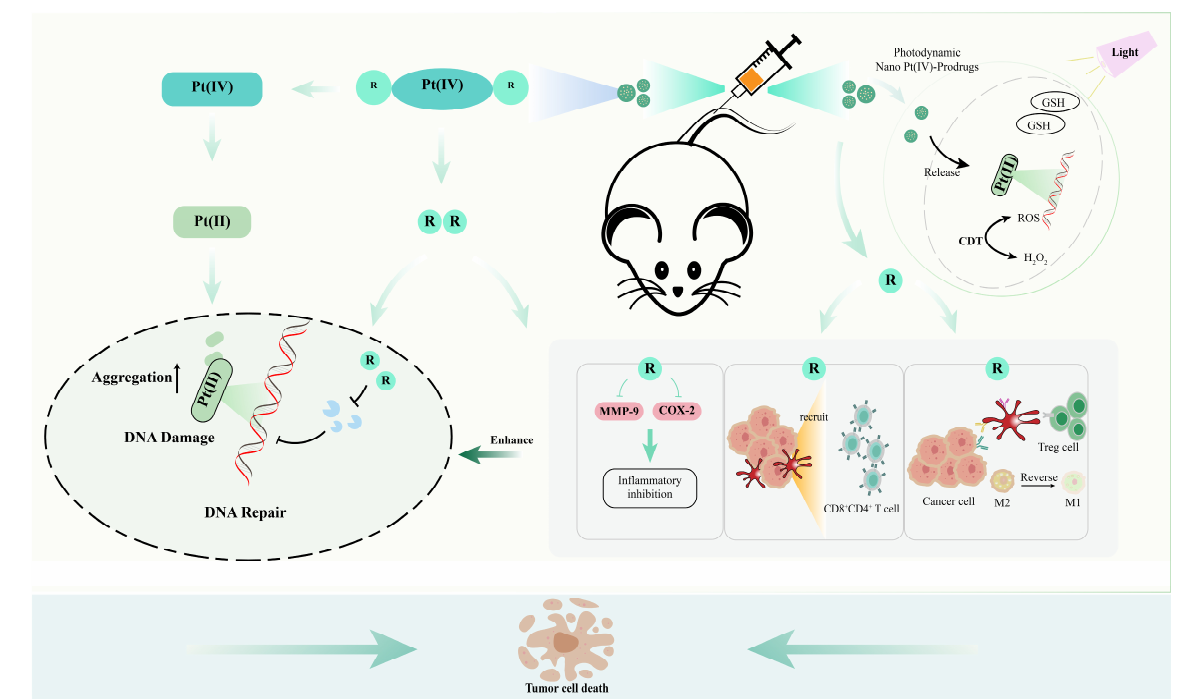
Figure 1. Multiple pathways to increase the antitumor effect of Pt-based drugs. The breakdown of nanomaterials or Pt prodrugs to yield Pt(II) drugs, which damage DNA, increase drug aggregation in cells or reduce DNA repair activity, can enhance tumor inhibition or reduce drug resistance. PTT/PDT can facilitate the targeted release of Pt-based drugs to enhance antitumor efficiency or reduce toxic side effects. In addition to their adjuvant role, axial ligands of Pt drugs can be involved in the immune response in vivo. They enhance the antitumor effects of Pt-based drugs by reversing macrophage polarization, recruiting immune cells and inhibiting tumor-associated inflammatory